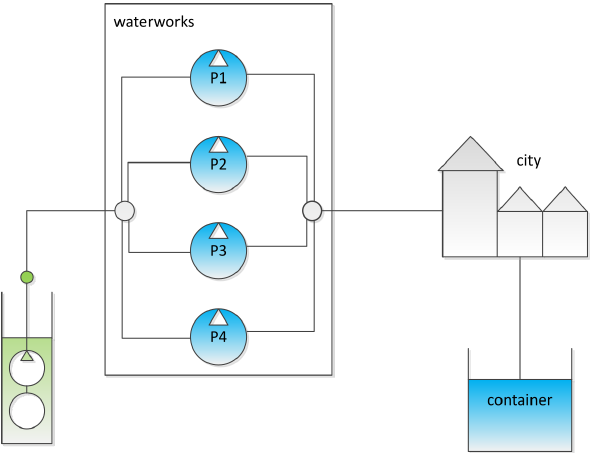
Figure 2. Scheme of the water supply system used for benchmarking. This figure is taken from the work in [42] and is slightly